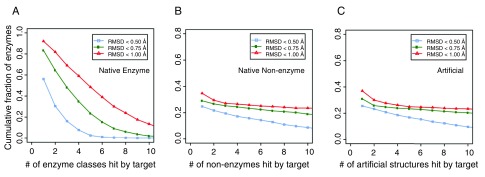
Cumulative fraction of enzymes whose active sites match pocket residues in (
A) other classes of enzymes in native structures with different first two digit Enzyme Commission (EC) numbers, (
B) in non-enzymes, and (
C) in ART structures. For each target enzyme, we count the number of alternative enzyme classes that contain at least a hit by the target enzyme at various root-mean-square-deviation (RMSD) cut-offs.